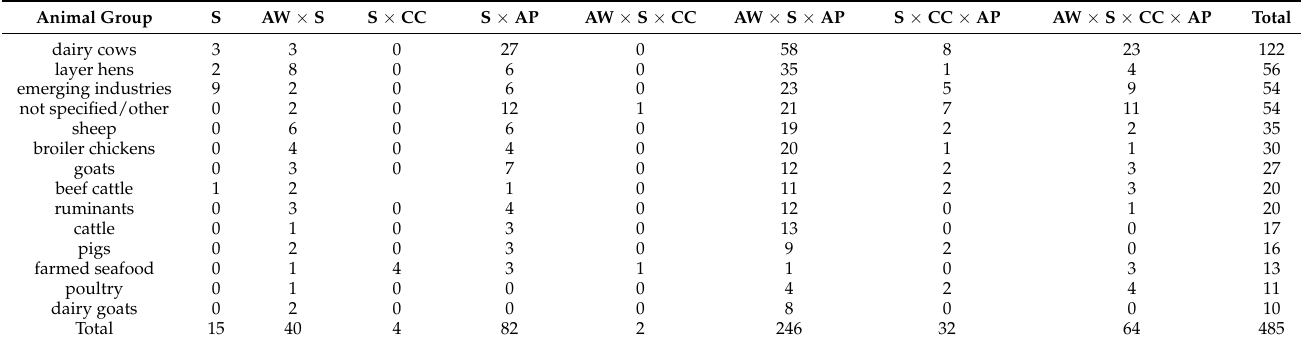
Table 4. Summary of articles discussing Stress (S) interaction with Animal Welfare—AW, Climate Change—CC, Animal Production—AP) in their research between